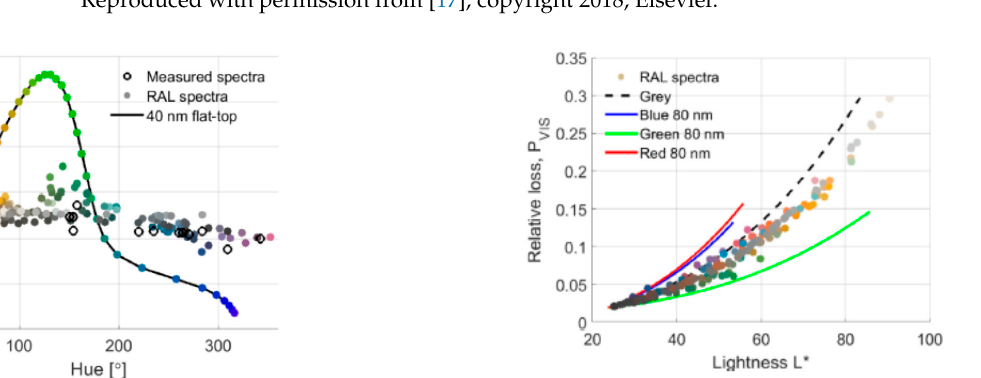
Figure 6. Example of reflectance spectra modelled by Røyset et al. [17]. On the left, the pill box monochromatic reflectance of blue, green, and red colours. On the right, smooth reflectance curves are generated by sinusoidal function wavelength transition, based on five main reflectance bands. Reproduced with permission from [17], copyright 2018, Elsevier.